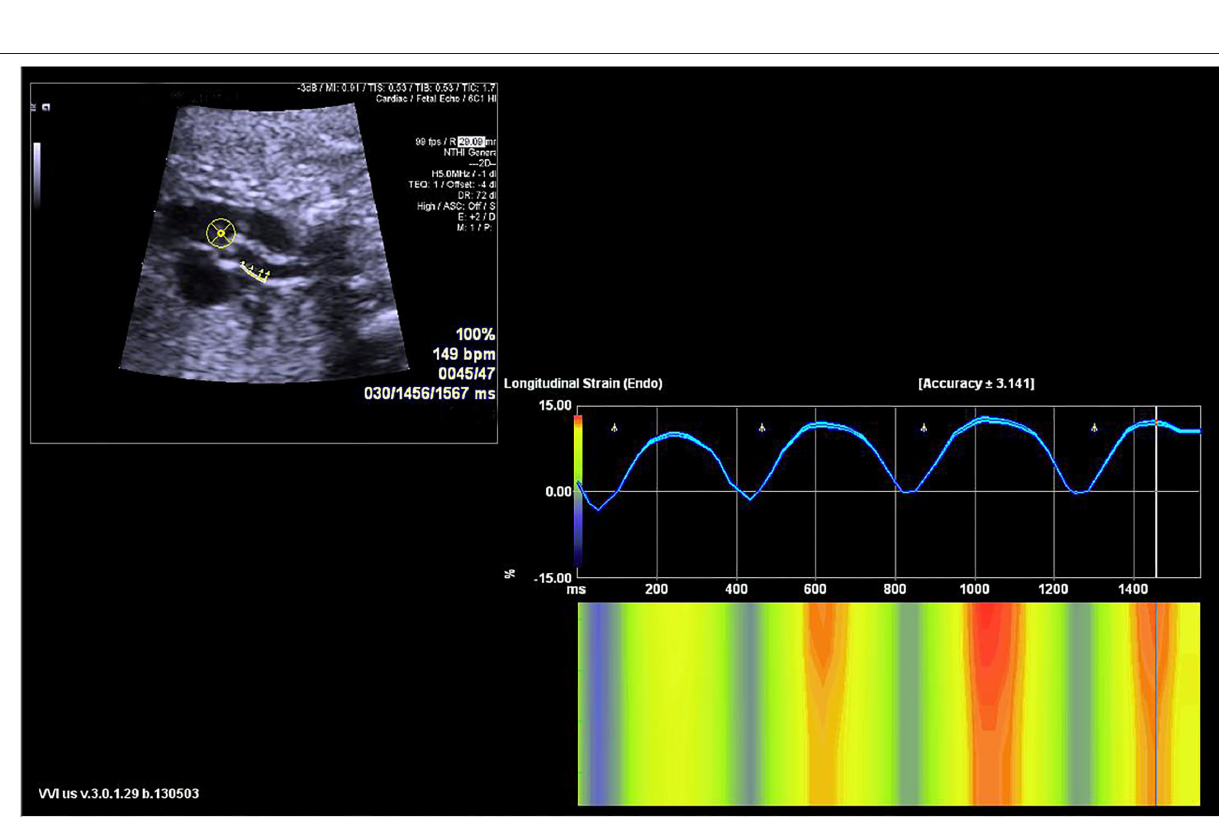
FIGURE 1 | The velocity vector image of the traced fetal ascending aorta is shown in the great artery short-axis view (A) . The circumferential strain curve during the cardiac cycle was automatically displayed in the segmental model with a specific color, and global circumferential strain (GCS) was recorded as the average of all segmental systolic peak circumferential strains (B) .